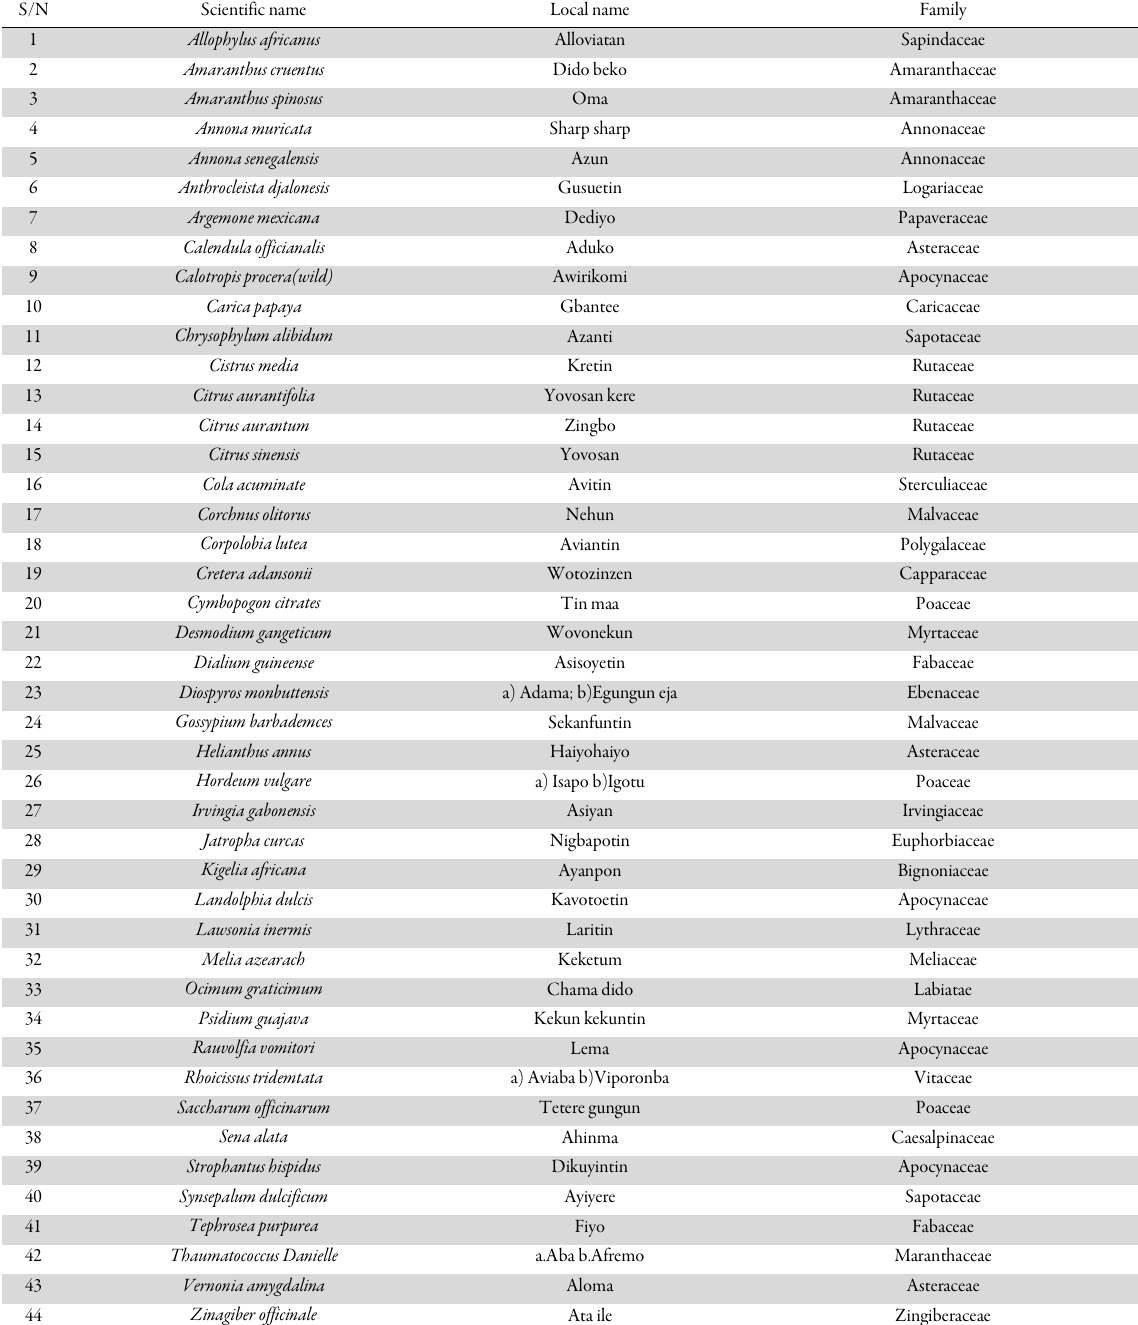
Table 2. Identified plant species valued for medicine in Badagry Local Government area of Lagos State